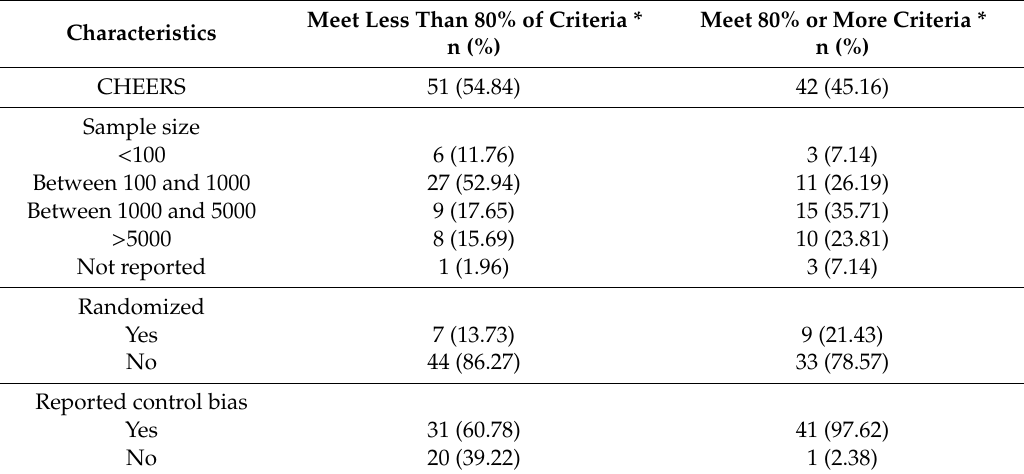
Figure 2. Quality assessment according CHEERS check list * . * Items 15 (Choice of model) and 16 (assumptions) only apply to mathematical models and were not scored. NA: Not apply Table 4. Relation between CHEERS and